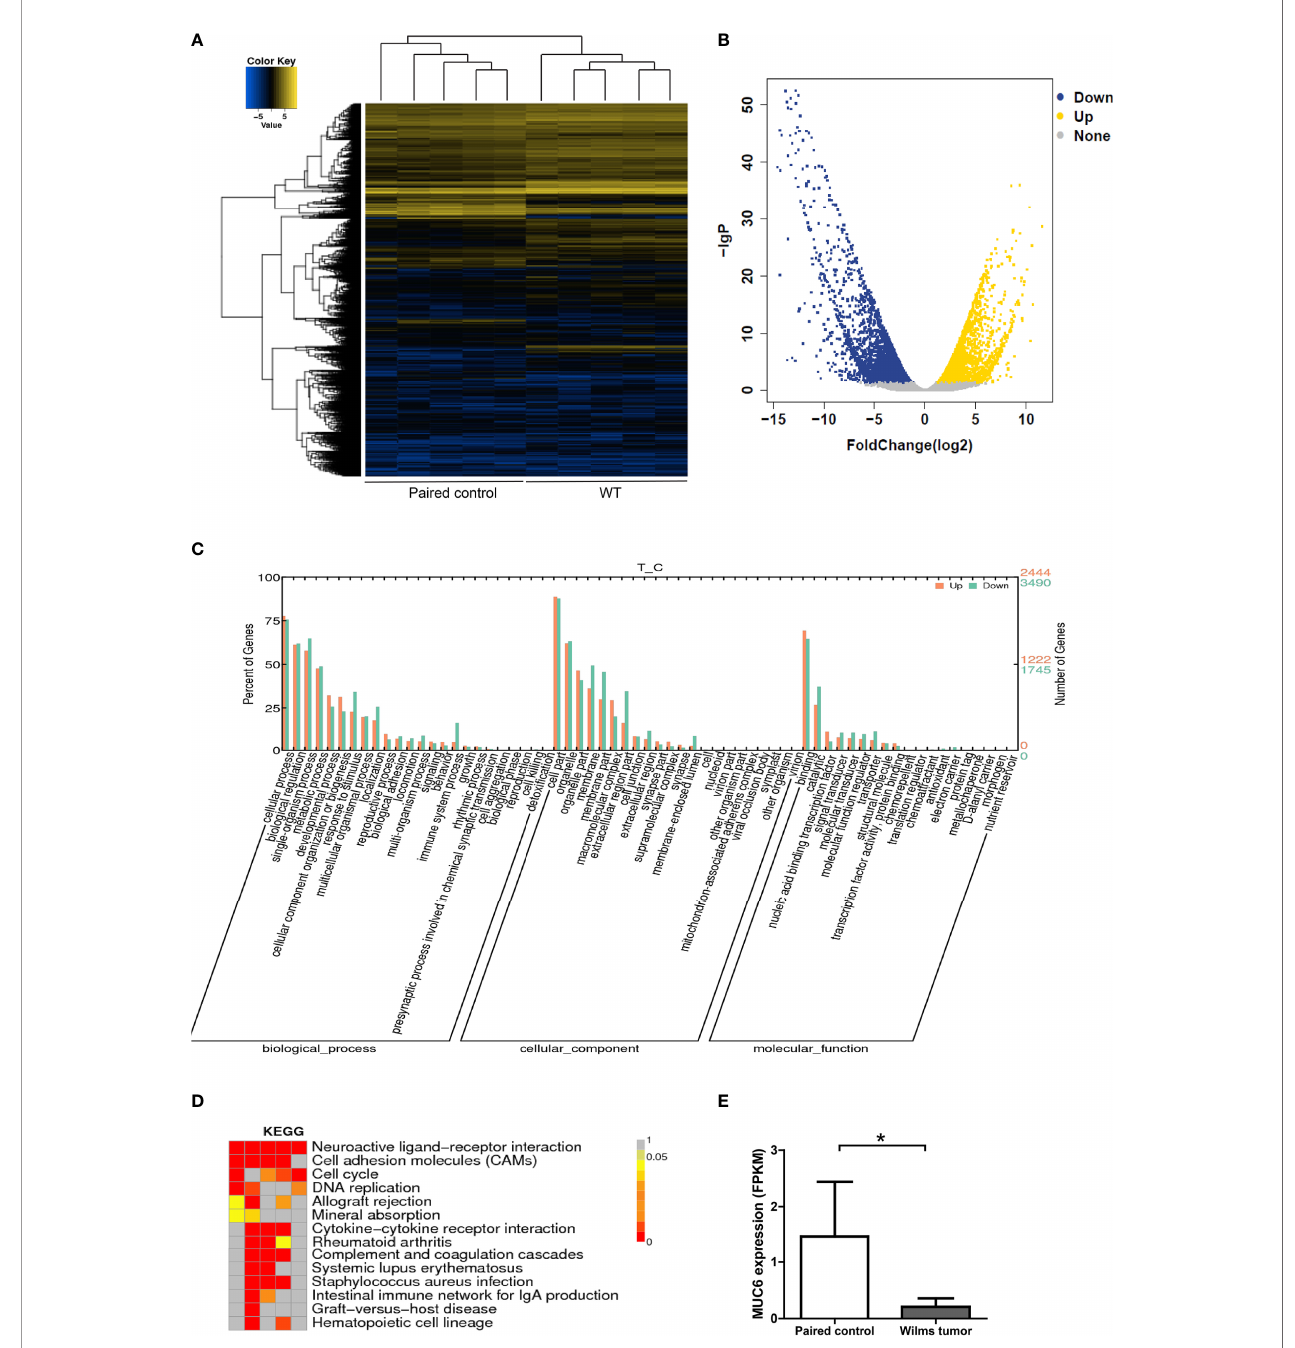
FIGURE 2 | RNA sequencing of WT samples. (A) Heatmap showing the gene expression pro fi ling of 5 pairs of WT samples. (B) Volcano plot of the differential gene expression. (C) Gene Ontology annotation showing the biological process, cellular component and molecular function of differentially expressed genes. (D) Signi fi cantly enriched KEGG pathways. (E) MUC6 mRNA level revealed by RNA sequencing in WT tissues and paired control tissues. effect on b -catenin mRNA level ( Figure 4I ), promoter activity terminal signal peptide and C-terminal HA tag, and over- ( Figure 4J ) or 3 ’ UTR activity ( Figure 4K ). Taken together, the expressed them in HEK293 and WiT49 cells, respectively. results from MUC6 knock-down and MUC-C over-expression MUC-C, but not MUC-N, reduced the protein levels of b - suggest that MUC6 suppressed b -catenin protein level likely via catenin and its target genes c-Myc, MMP7 and survivin post-translational mechanism. ( Figure 4H ). Consistently, MUC-C over-expression had no